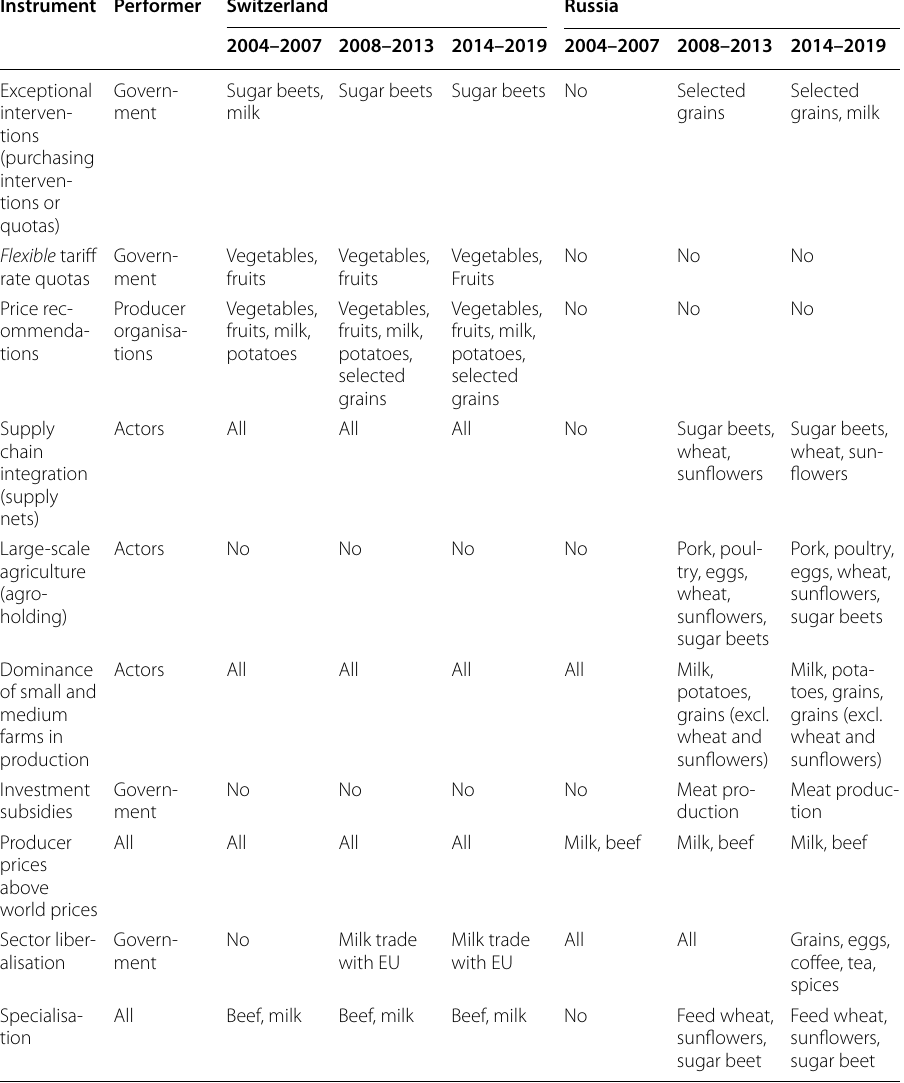
Table 1 Institutional instruments of price stabilisation Instrument